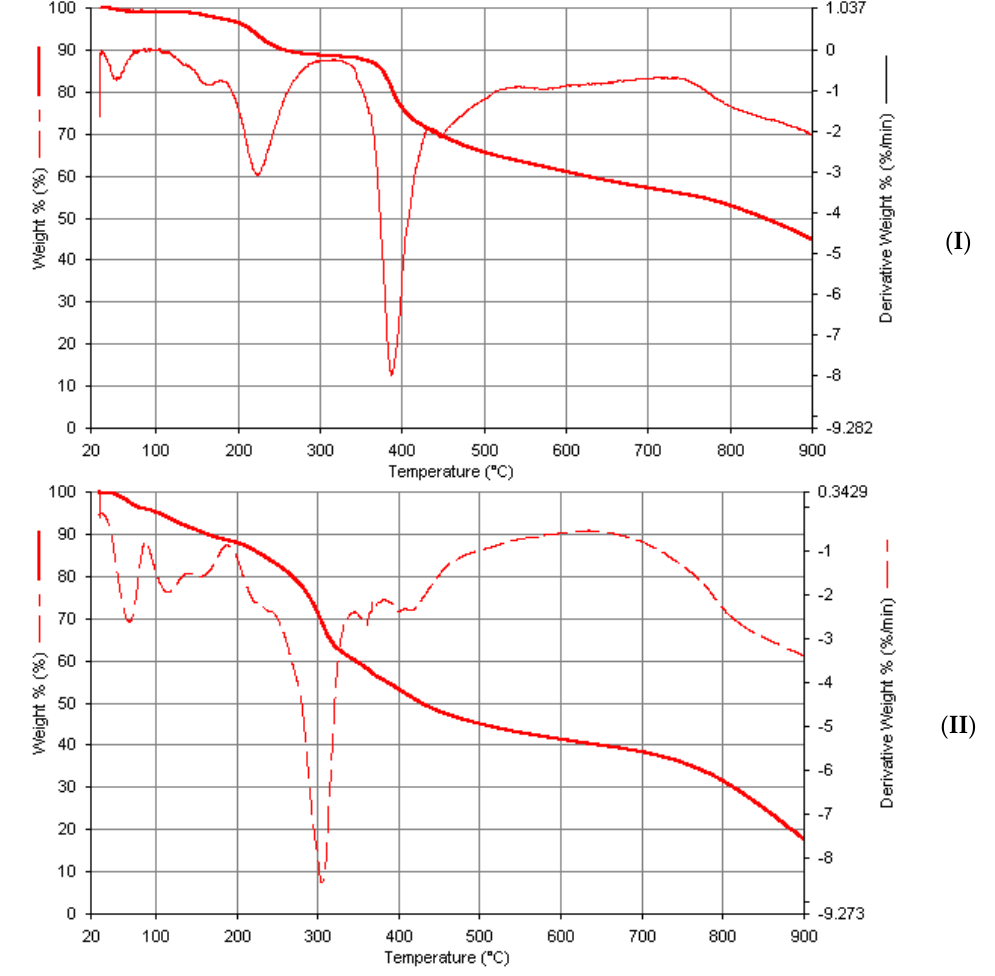
Figure 11. Thermogravimetric analysis curves of metal complexes. ( I ) Mn(Bmpp-Dh) 2 (H 2 O) 2 ; and ( II ) Mn(Ampp-Dh) 2 (H 2 O) 2 ∙ H 2 O.